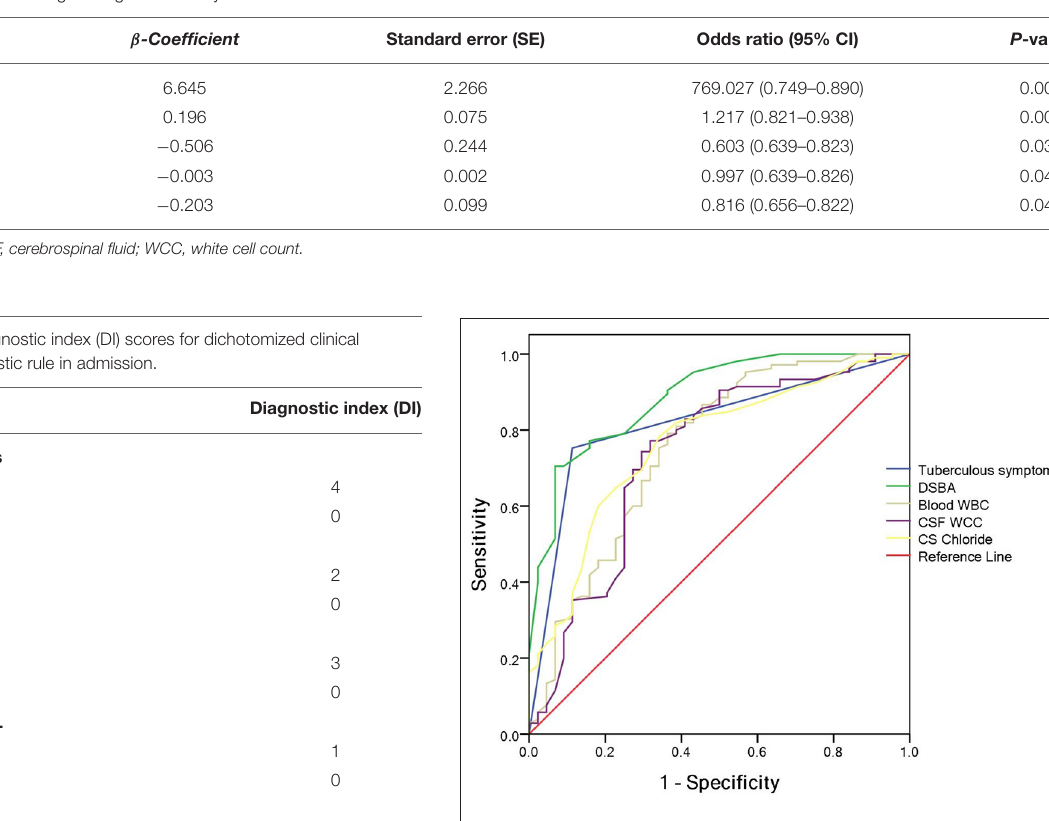
FIGURE 1 | Independent predictors of tuberculous meningitis